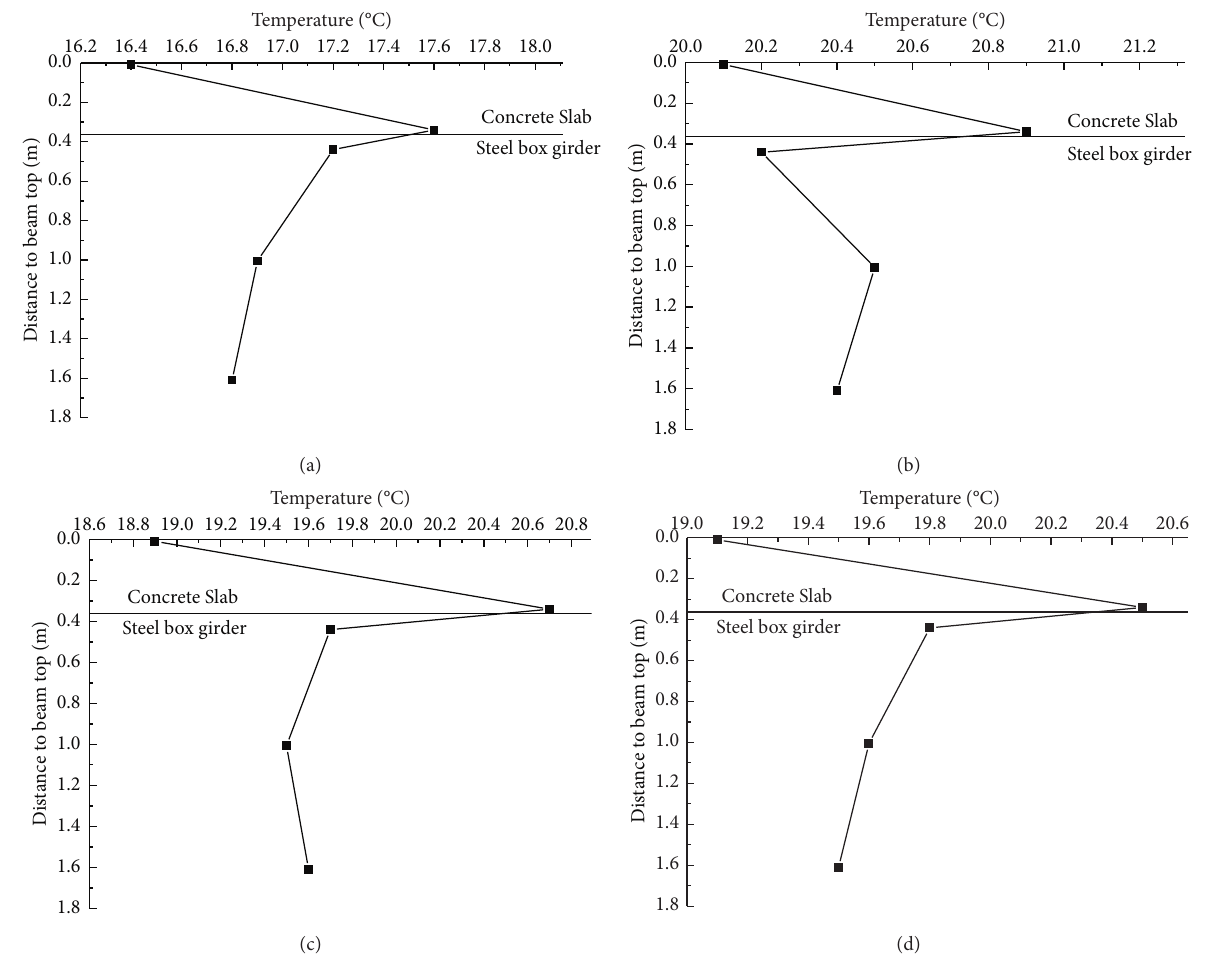
Figure 11: Most unfavourable curves of the temperature drop gradient on the vertical section. (a) West section on June 7. (b) East section on June 7. (c) West section on June 11. (d) East section on June 11.